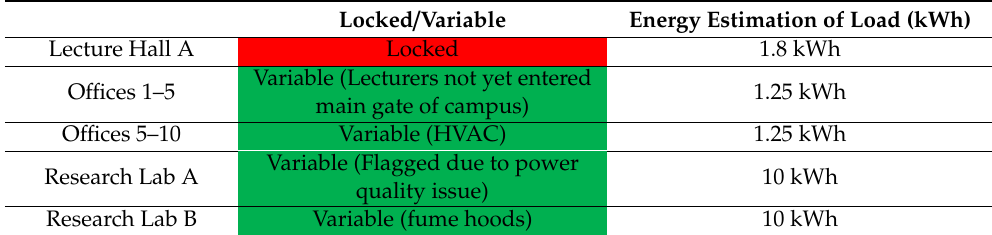
Table 2. Simplistic response of a departmental energy policy framework over a 0.5 h time-step (with campus IoT